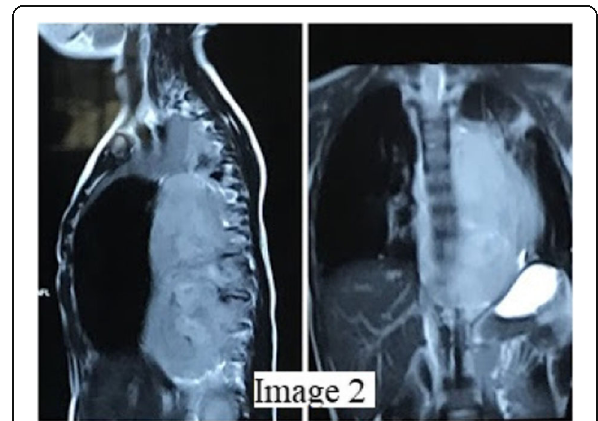
Fig. 2 MRI scan of the thorax and the spine showing the extent of the lesion and spinal canal infiltration